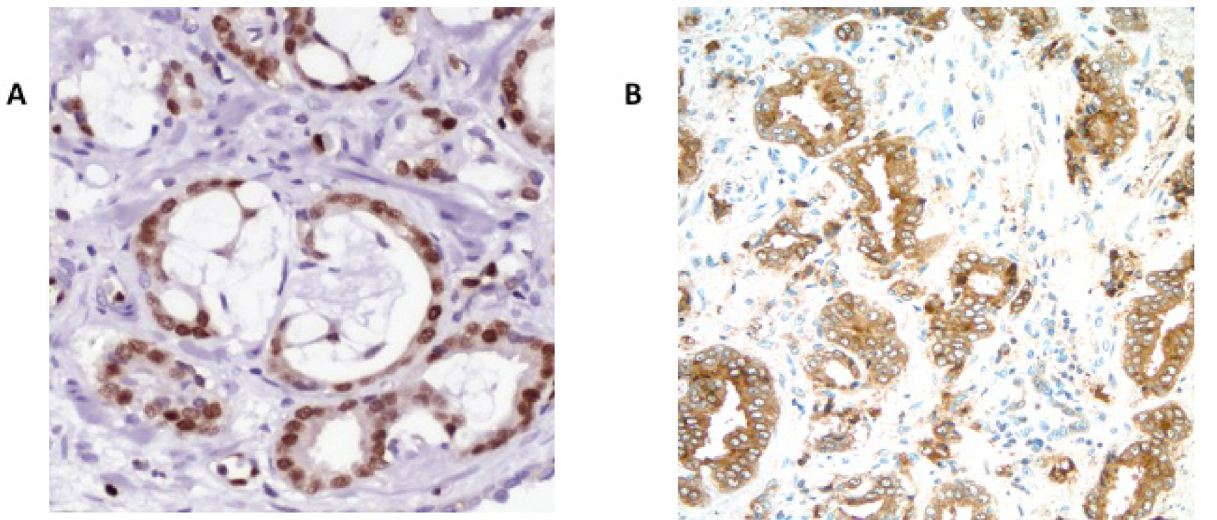
Fig 1. Immunohistochemical staining showing high level expression of A) ERG – nuclear staining, and B) SPINK1 with cytoplasmic staining.